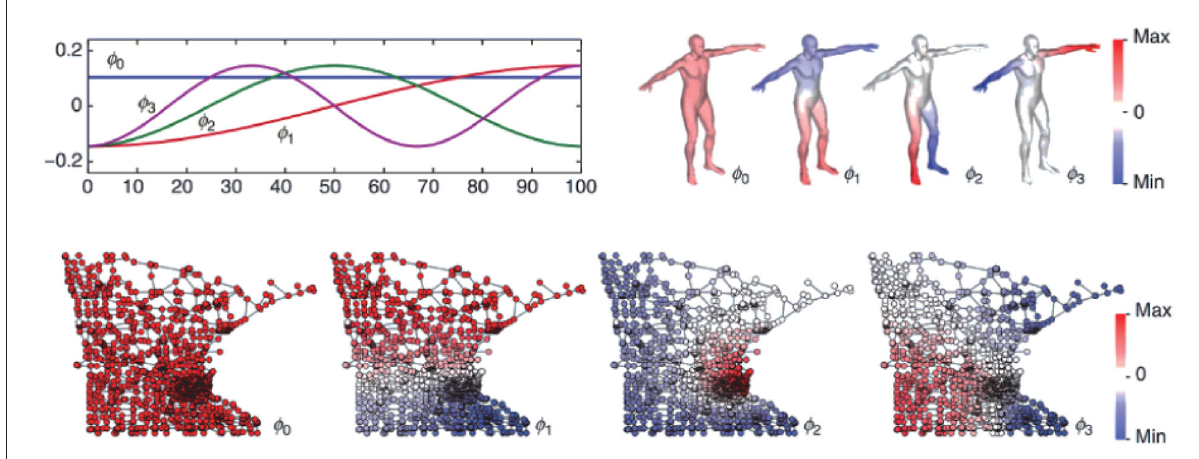
FIGURE1 Example of the four Laplacian eigenfunctions φ 0 , ..., φ 3 on a Euclidean domain (1D line, top left) and non-Euclidean domains (human shape modeled as a 2D manifold, top right; and Minnesota road graph, bottom). In the Euclidean case, the result is the standard Fourier basis